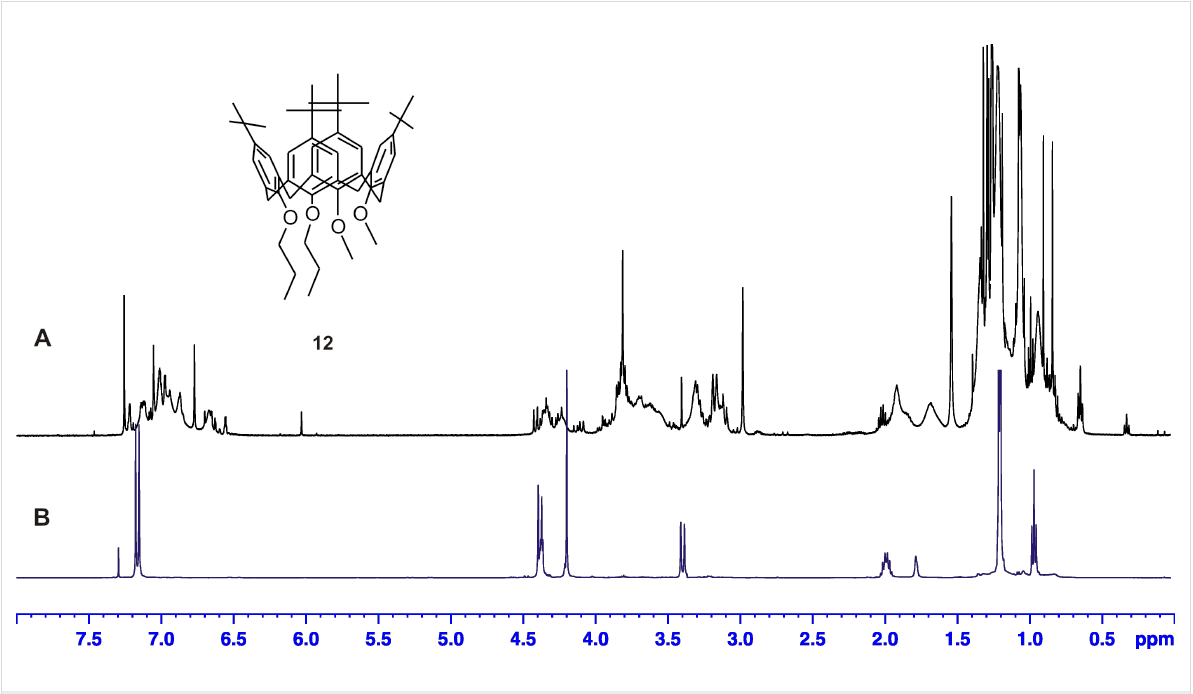
Figure 2: 1 H NMR spectrum (CDCl 3 , 293 K, 500 MHz) of calixarene ether 12 before ( A ) and after the addition of NaI/acetonitrile- d 3 ( B ).